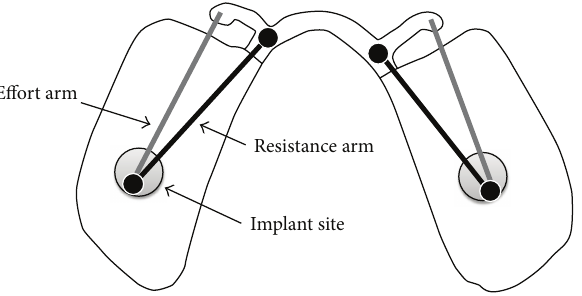
Figure 9: Lever created by the effort arm in relation to the resistance arm, demonstrating the increase in the lever as it extends anteriorly.